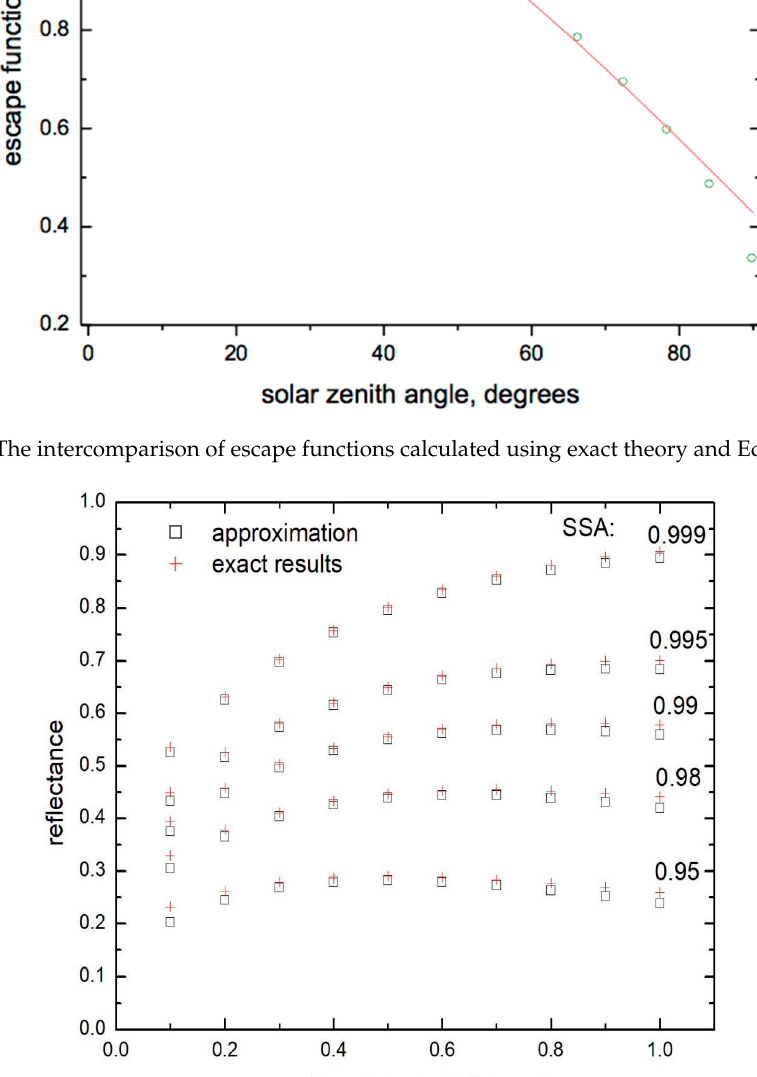
Figure 3. The plane albedo as the function of the cosine of the solar zenith angle at various values of single scattering albedo for the semi-infinite snow layer with the asymmetry parameter g = 0.75. The exact results are presented together with two approximations (boxes-Equation (13), circles-calculation of plane albedo using Equations (15) and (16)).